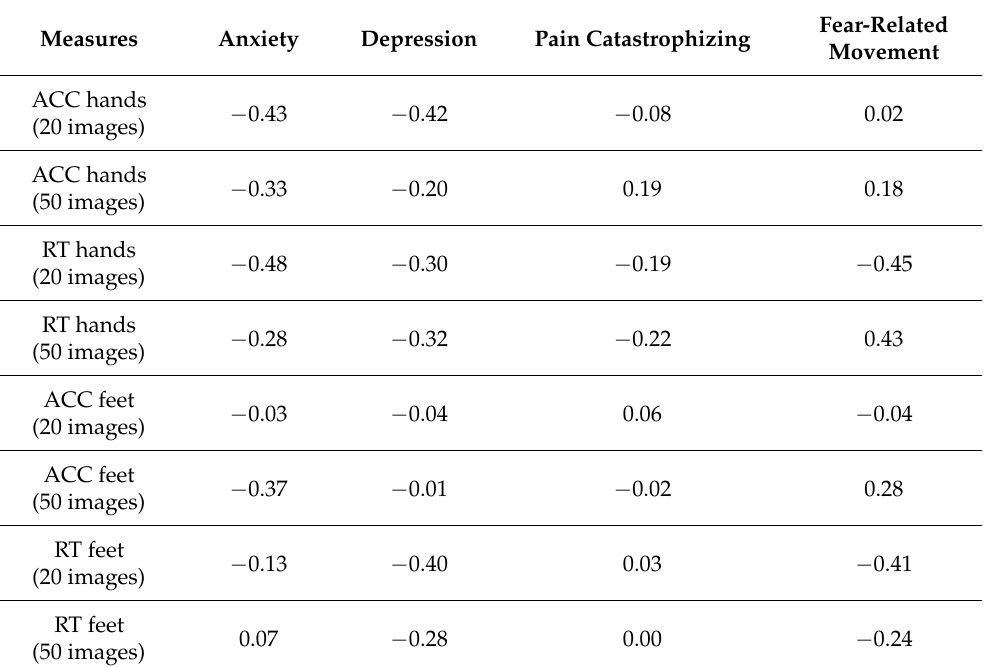
Table 4. Correlation coefficients between performance on the lateral limb discrimination and psycho- logical